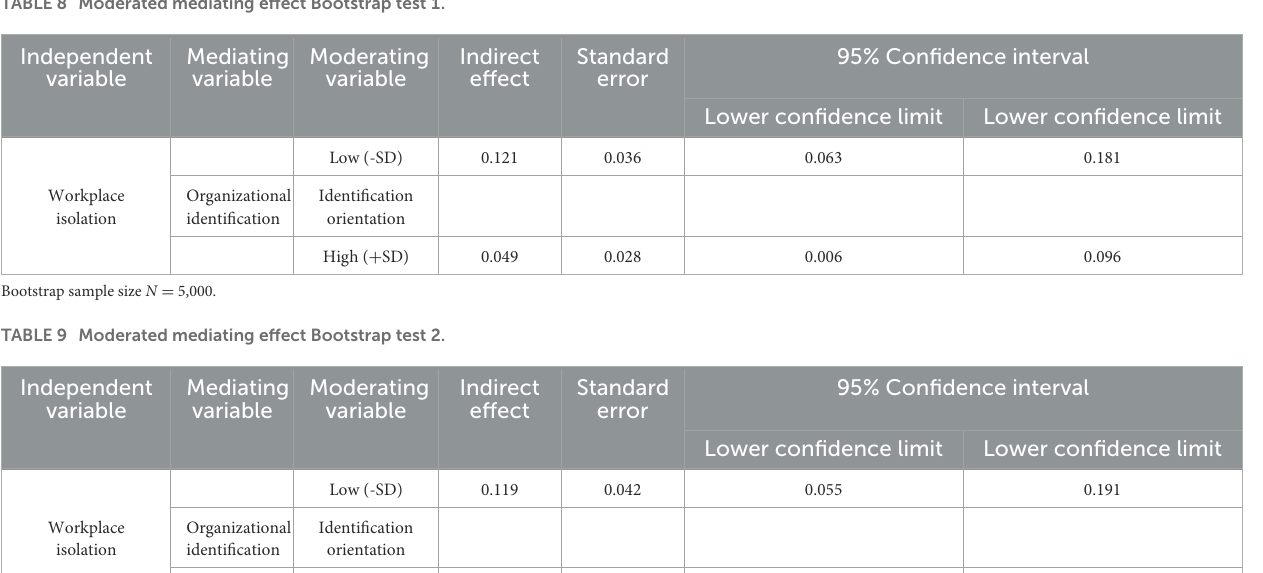
TABLE 8 Moderated mediating effect Bootstrap test 1.